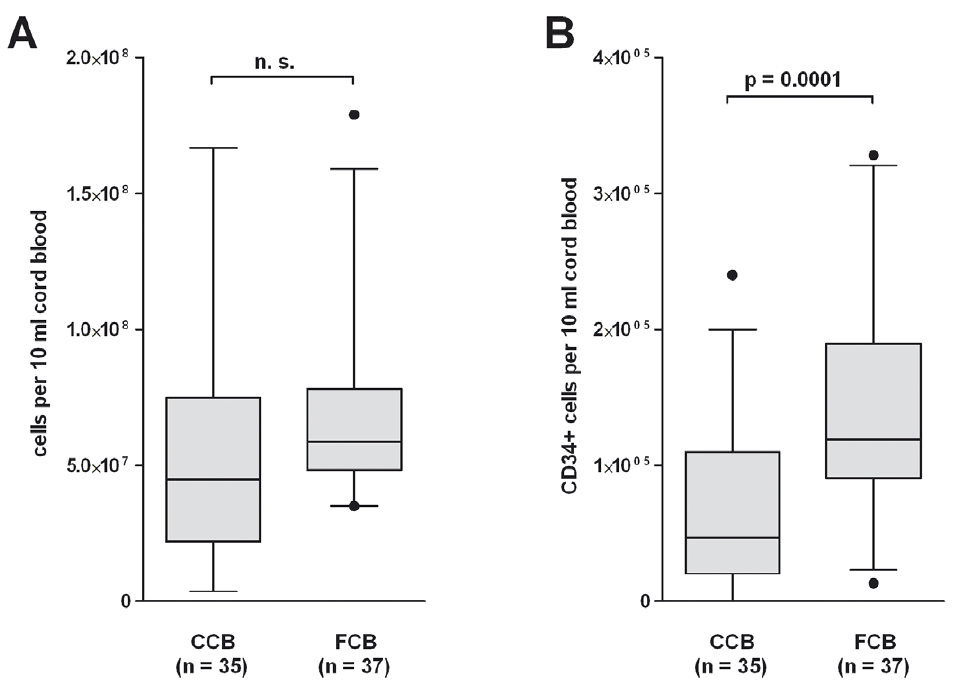
Figure 1. Differences and parallelism in the yield of CD34 + -cell-purifications from FCB and blood bank CCB. (A) MNC were isolated from CCB or FCB by washing with DNAse buffer or Ficoll-paque density gradient centrifugation as described in materials and methods. The total number of MNC per 10 ml cord blood is shown. (B) CD34 + cells were isolated from MNC by a positive magnetic separation of CD34 + cells. The number of CD34 + cells per 10 ml cord blood is shown.